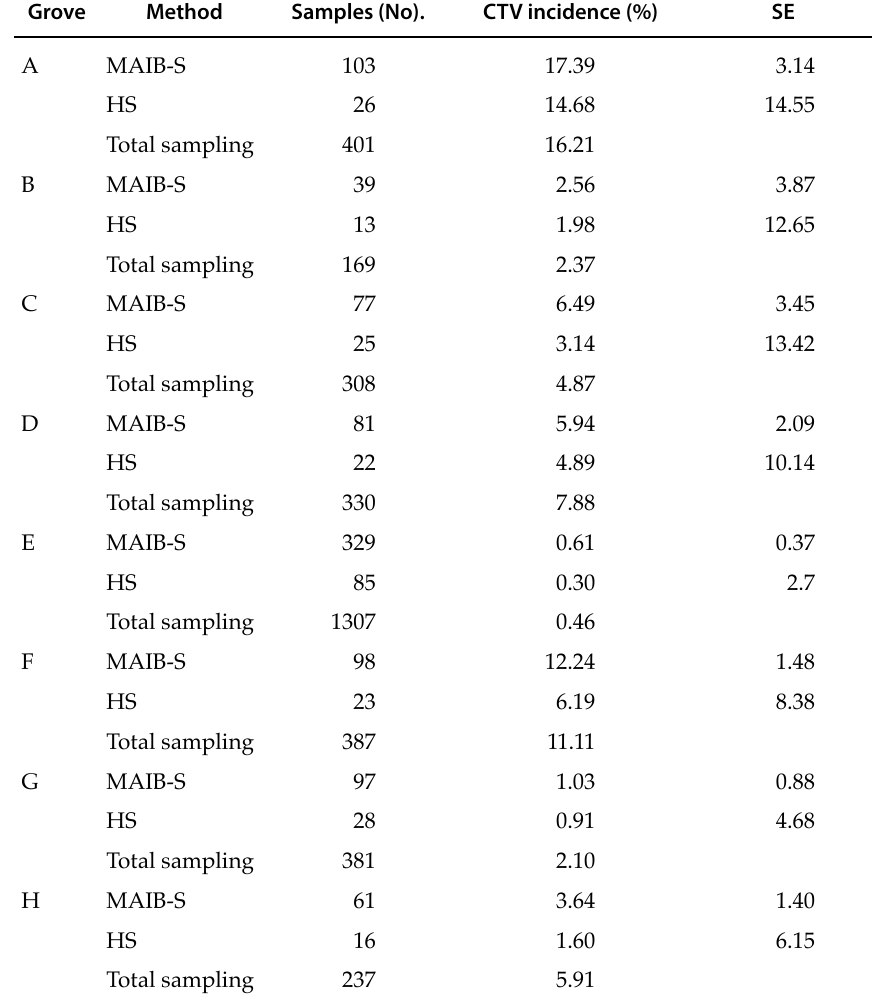
Table 2 . The actual incidence of Citrus tristeza virus (CTV) in eight groves (A-H) and the results obtained from the Mediter- ranean Agronomic Institute of Bari sampling method (MAIB-S) and the Hierarchical Sampling method (HS). The statistical data provided by Statistica 7 are